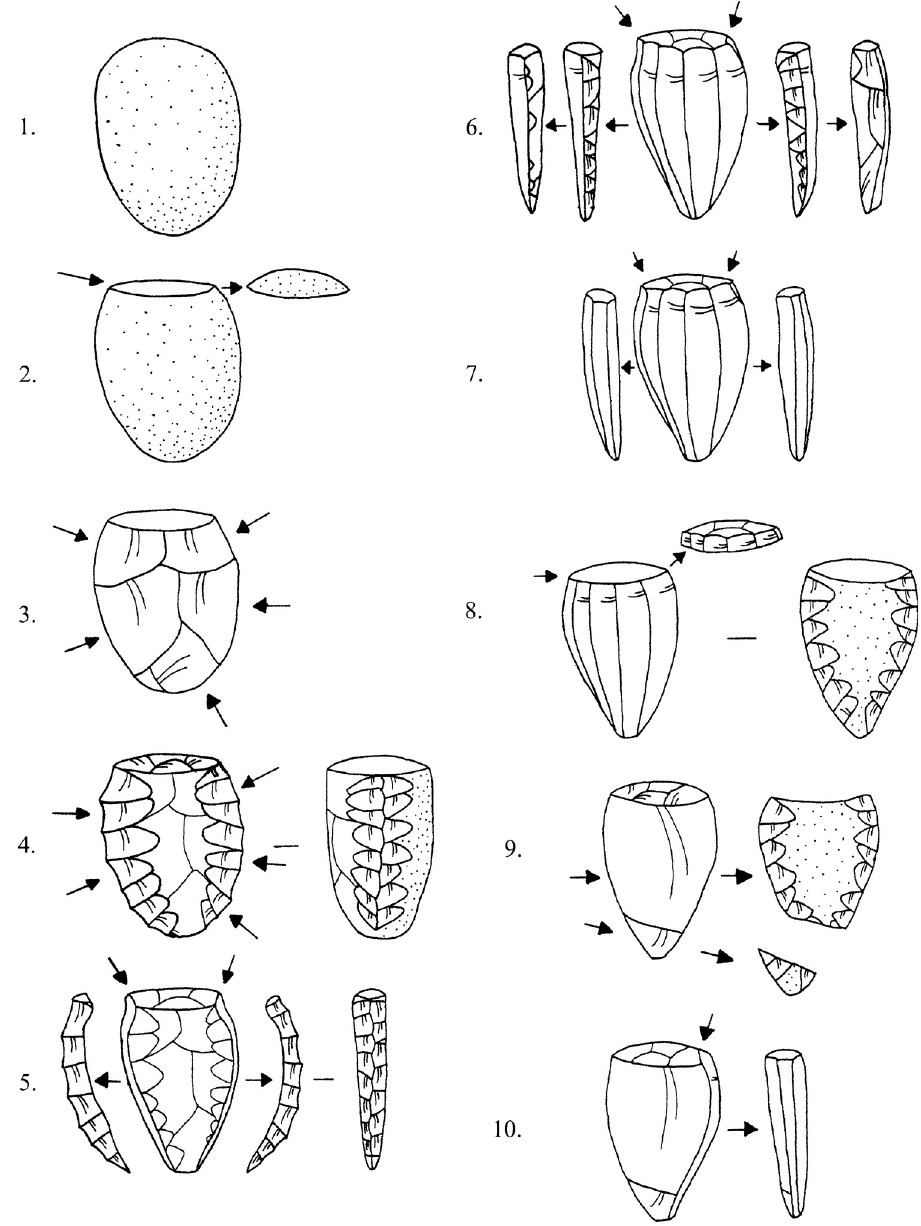
Fig 5. General reconstruction of obsidian blade-core preparation and reduction sequence at Bronze Age Malia. Reproduced from [116]; original copyright with the authors.